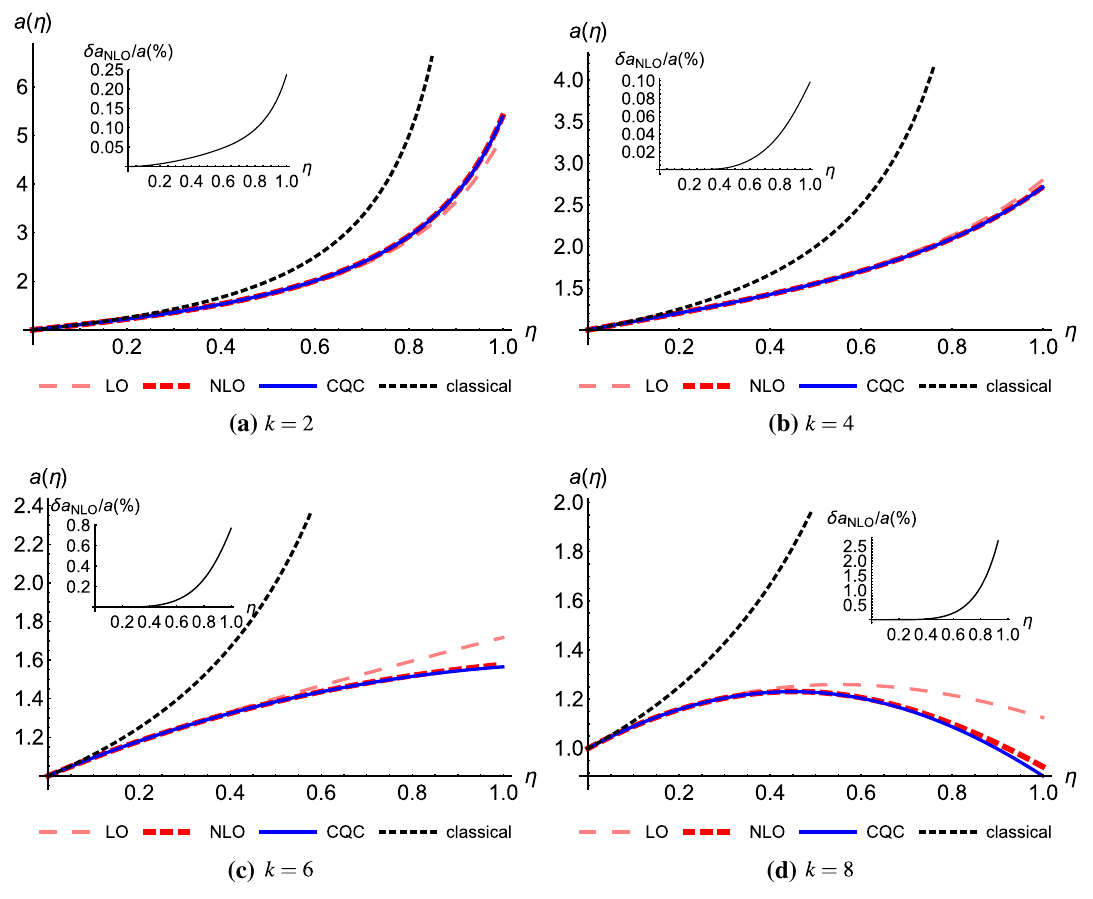
Fig. 6 Scale factor, a , obtained using the CQC and the leading order (LO) and next-to-leading order (NLO) of the perturbative-iterative method for k = 2 , 4 , 6 , 8 with a 0 = 1 and h = 1. Inset plot shows